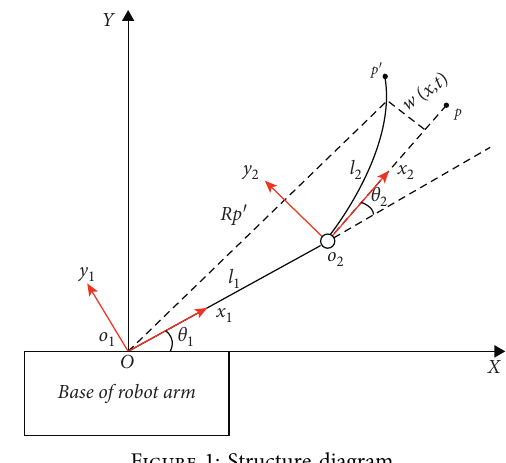
Figure 1: Structure diagram.